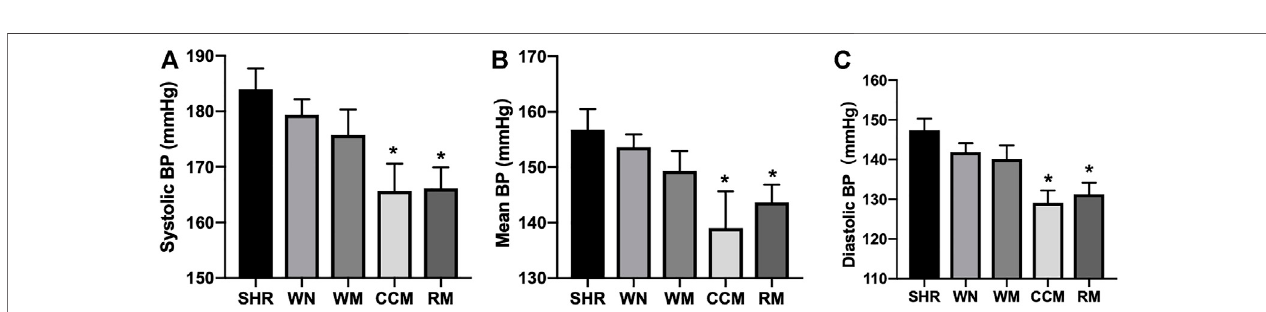
FIGURE 2 | Chinese classical Music (CCM) therapy lowers systemic BPs in spontaneously hypertensive rats (SHRs). Male SHRs at the age of 8 – 12 weeks old fed withnormaldietwereexposuretoindicatedmusictherapy.WN,whitenoise;WM,Westernclassicalmusic;CCM,Chineseclassicalmusic;RM,Rockmusic. (A) Systolic BP, (B) mean BP and (C) diastolic BP were analyzed. Quantitative results are expressed as mean ± SEM. N is 10 – 15 in each group. * p < 0.05 vs. SHR mice.